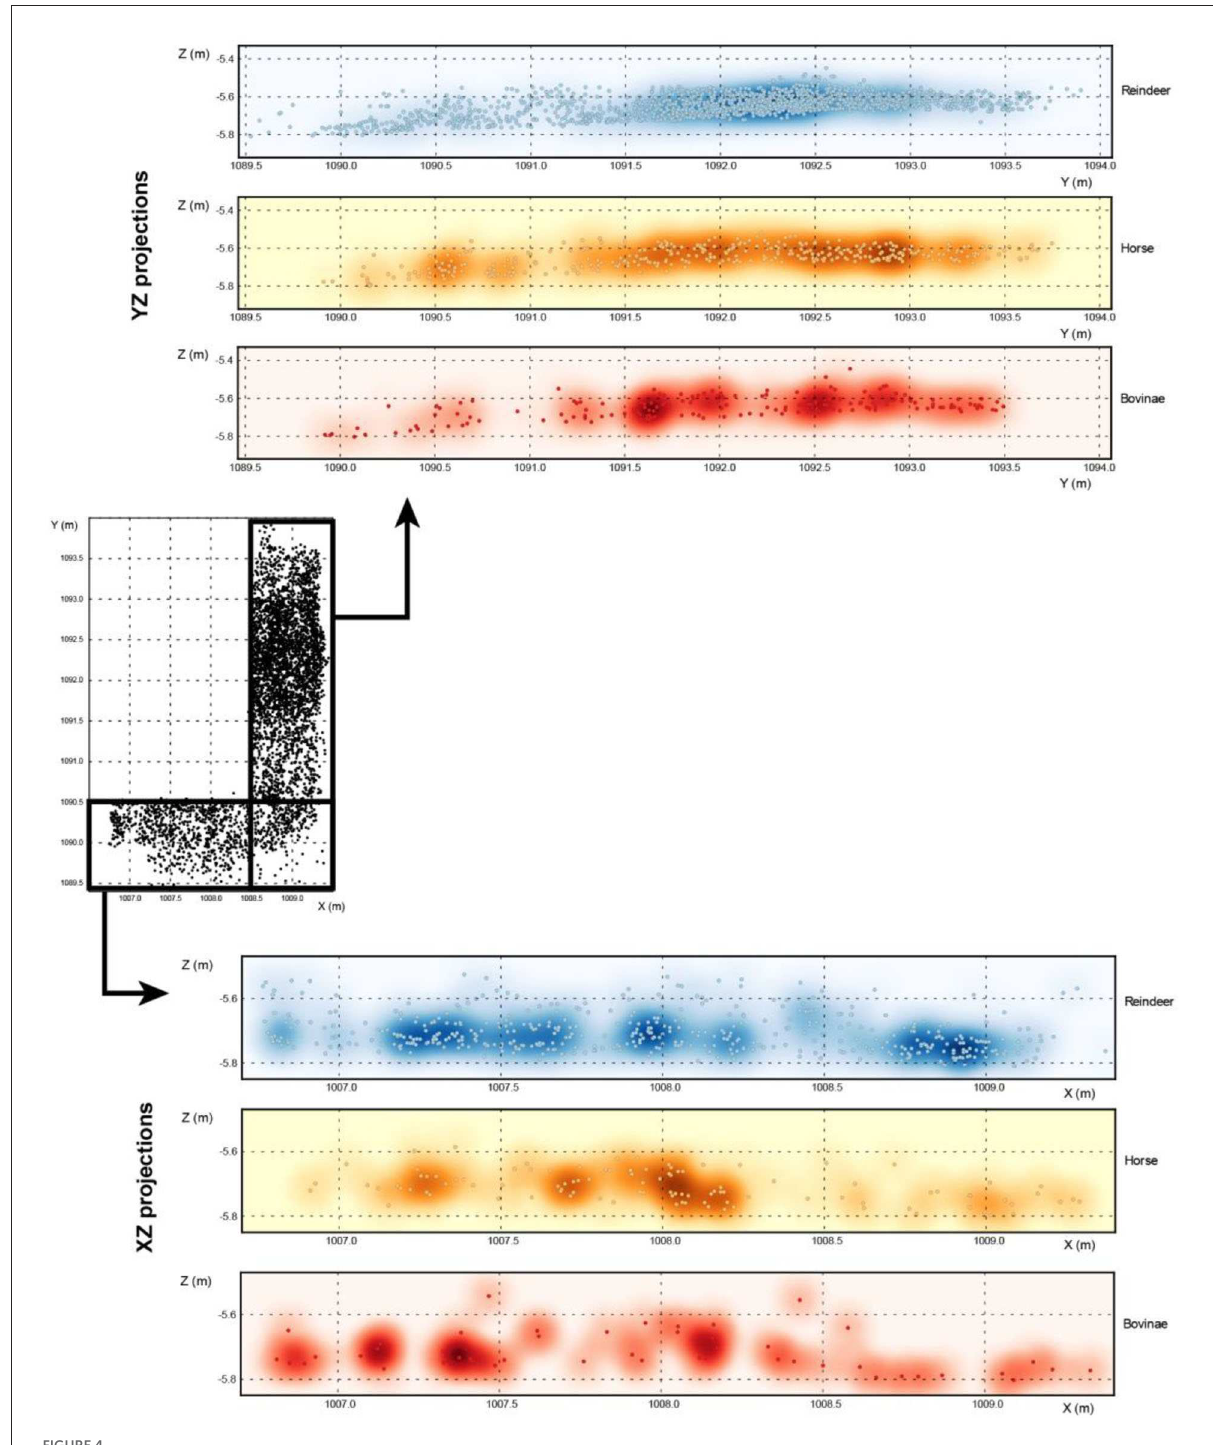
FIGURE4 Spatial distribution of the three main taxa on sagittal (YZ) and frontal (XZ) projections (dots: identified remains, color background: density).